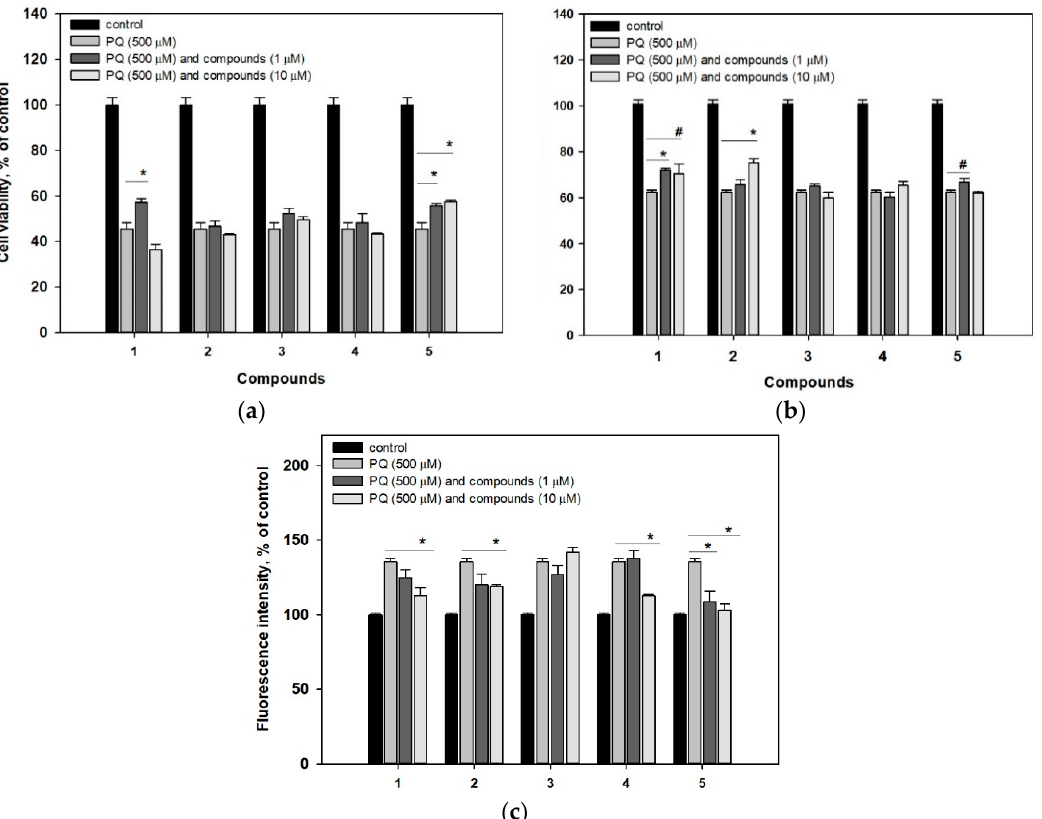
Figure 2. Influence of compounds 1 – 5 on PQ-treated Neuro-2a cell viability. ( a ) The viability of cells treated with compounds and PQ was measured by the MTT assay. ( b ) The viability of cells treated with compounds and PQ was measured by the FDA assay. ( c ) PI-straining cells treated with compounds and PQ. Each bar represents the mean ± SEM of three independent replicates. (*) and (#), indicate, respectively, p < 0.05 and 0.01 versus PQ-treated cells. The difference between control and PQ-treated cells was considered significant ( p < 0.05).